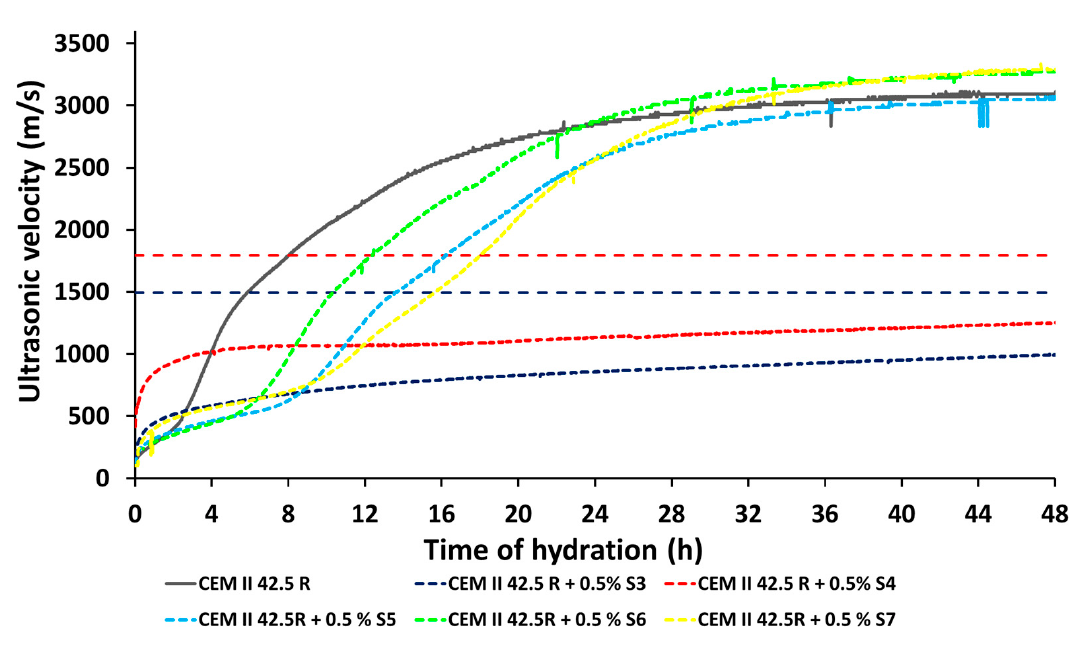
Figure 10. Study of the setting time through Ultrasonic measurements of the CEM II 42.5 R at w/c = 0.5 and with 0.5% bwoc of additives.